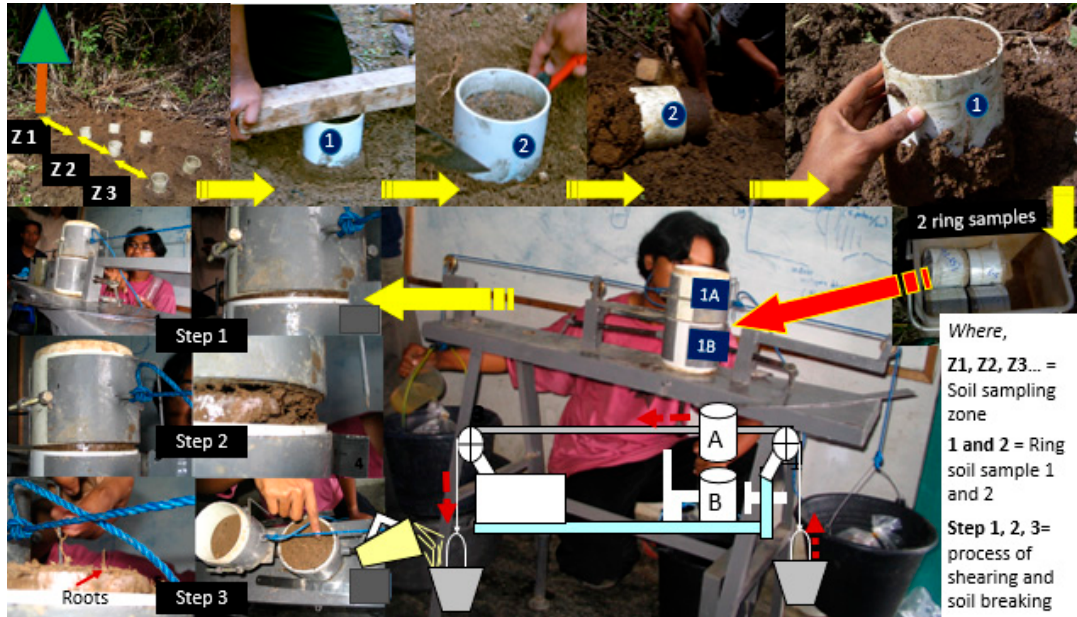
Figure 2. Taking soil samples in the study site in a double ring and measuring soil shear resistance by increasing the pull by adding water to a bucket until the upper ring moves.